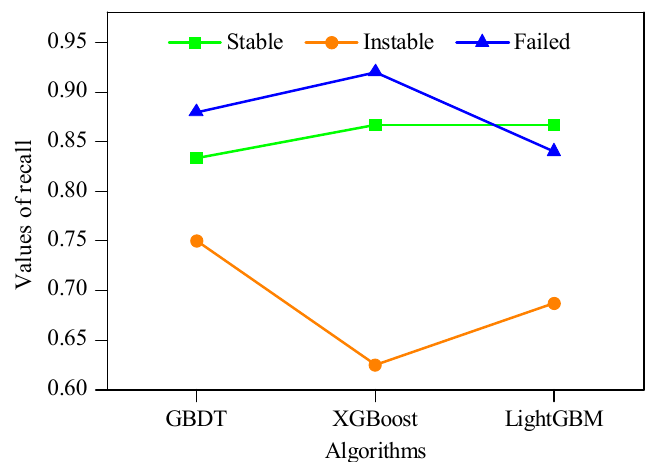
Figure 9. Recall values of algorithms for each stability level.